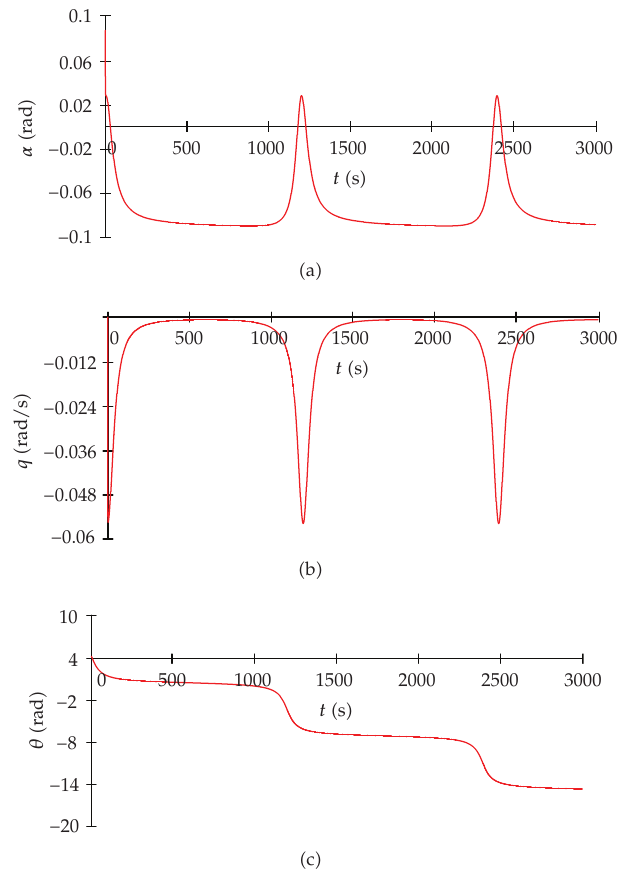
(cid:7) − 0 . 04678 (cid:5) rad (cid:6) (cid:7) − 2 . 681 ◦ → δ (cid:6)(cid:6) (cid:7) 0 . 048 (cid:5) rad (cid:6) (cid:7) 2 . 751 ◦ and the starting e e (cid:7) 0 (cid:5) rad / sec (cid:6) ; θ (cid:6) (cid:7) 0 . 1593297 (cid:5) rad (cid:6) (cid:7) 9 . 133 ◦ . 1 1